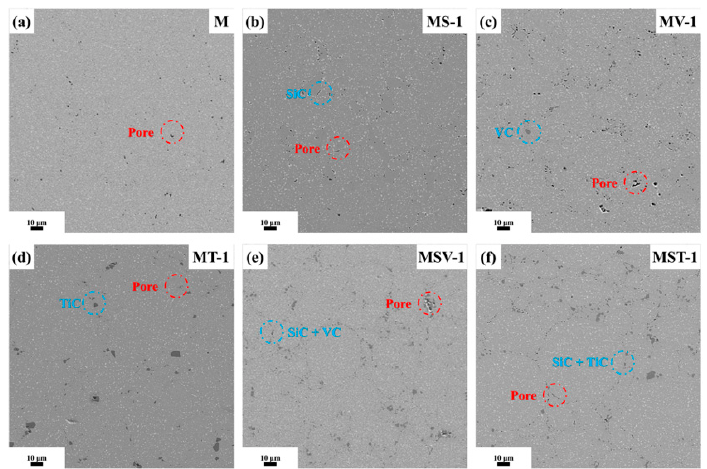
Figure 4. The SEM-SE micrographs of the S390 MMCs with different volume fractions of carbide. ( a ) M; ( b ) MS-1; ( c ) MV-1; ( d ) MT-1; ( e ) MSV-1; ( f )